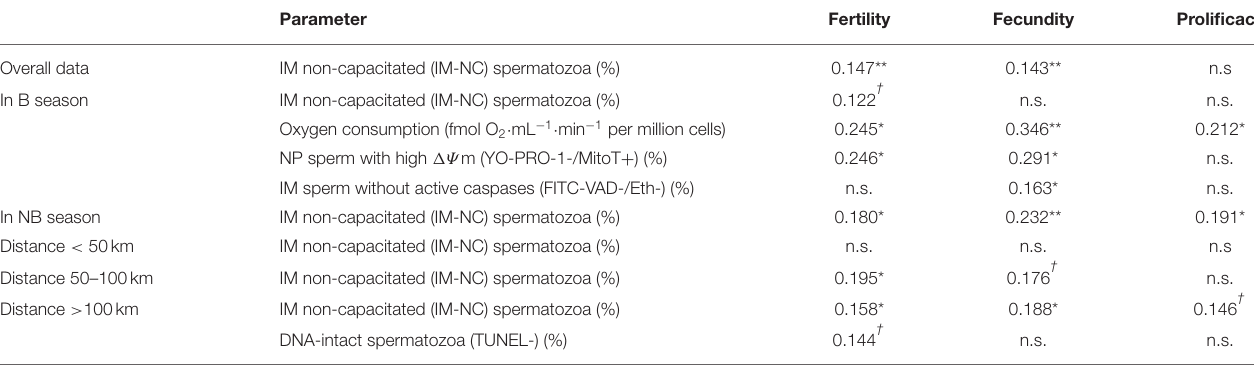
TABLE 5 | Spearman’s rank correlation coefficient (Spearman’s ρ ) between some analyzed sperm parameters and the reproductive results obtained after artificial insemination, considering overall data and data separated by season or farm distance to the semen collection point.